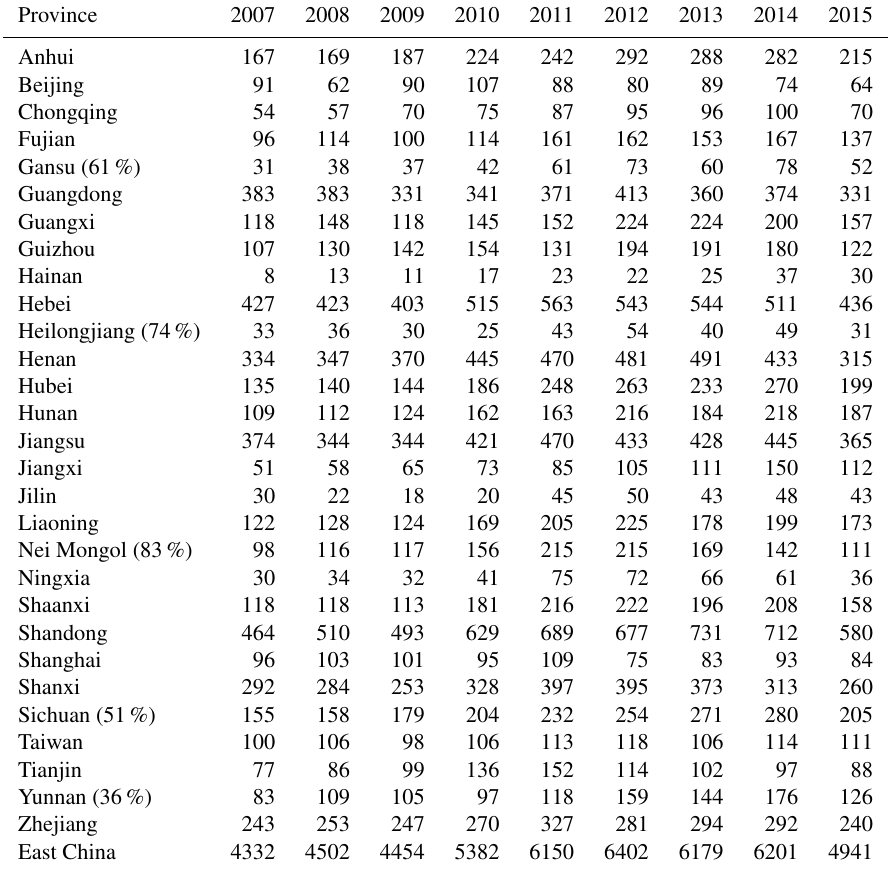
Table A2. Annual NO x emissions (Gg Nyear − 1 ) per province in the domain of DECSO (in parentheses the fraction of provincial area considered) derived from OMI